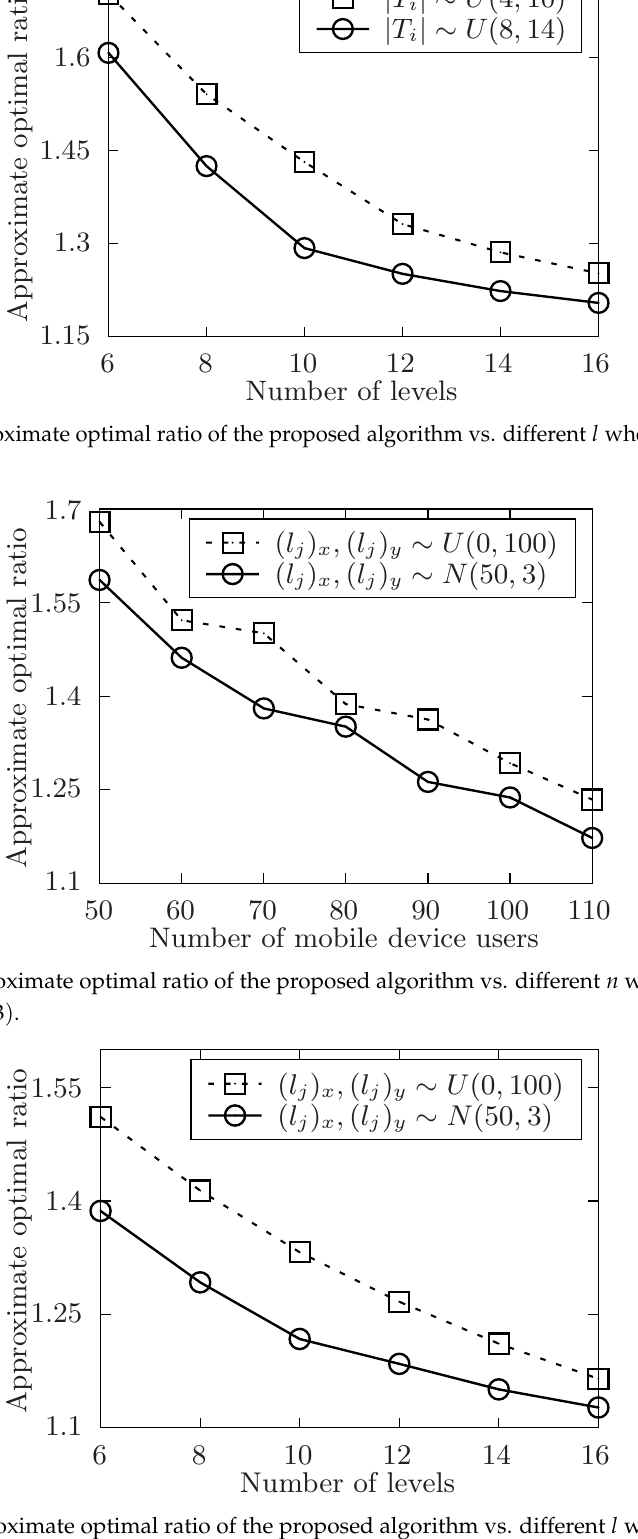
Figure 9. The approximate optimal ratio of the proposed algorithm vs. different l when ( l j ) x , ( l j ) y ∼ U ( 0,100 ) or N ( 50,3 )